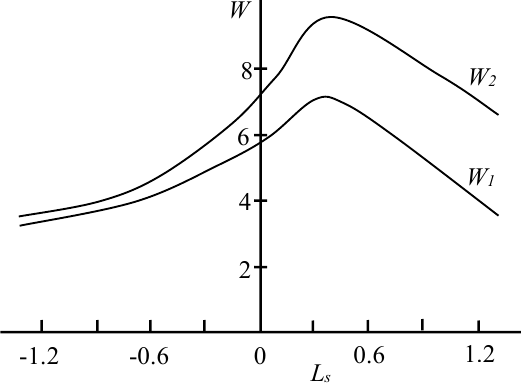
Figure 5 ： Energy of the electromagnetic wave concentrated in the volume of space where the intensity decreases up to 2 times ( W 1 ) or to value 2 ( W 2 ).